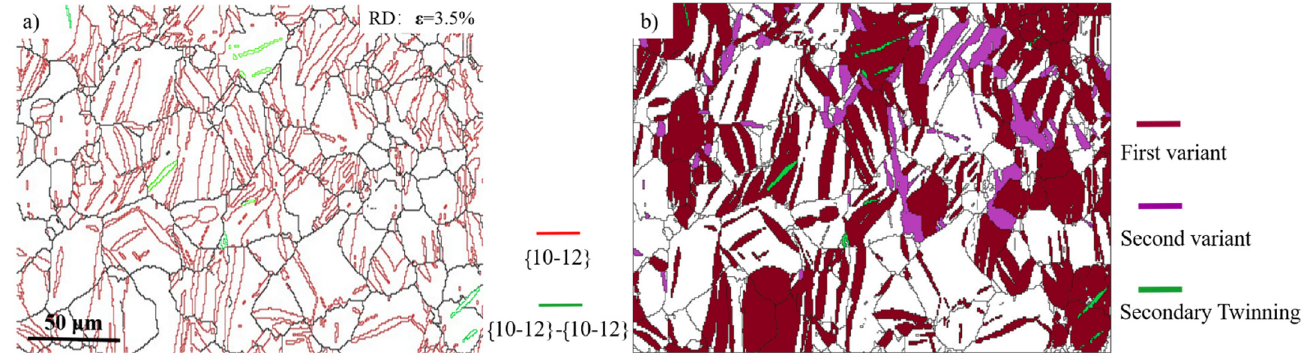
Figure 5. ( a ) The {10–12} primary tension twin and {10–12}-{10–12} secondary twin boundaries are presented in red (86.5° < 11–20 > ± 5°) and green (34° < 11–20 > ± 5°), respectively. ( b ) Primary twins with the first variant and second variant are shown in brown and purple, respectively. In addition, the secondary twins are plotted in green. The two maps correspond to strains of 3.5%.